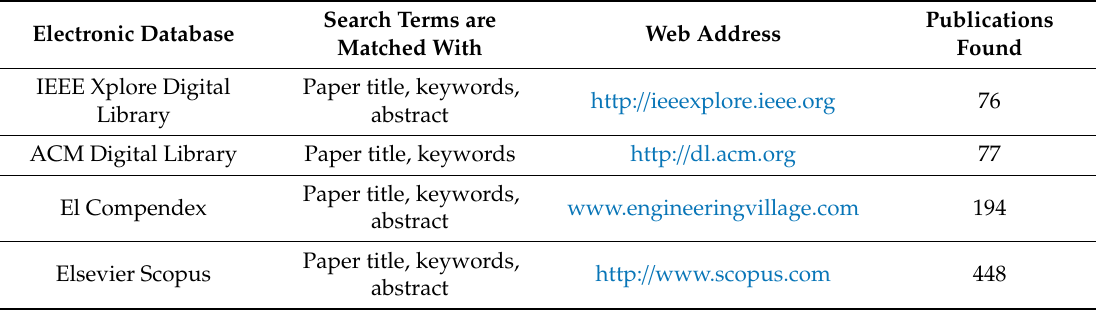
Table 2. Electronic databases for the automatic search included in the